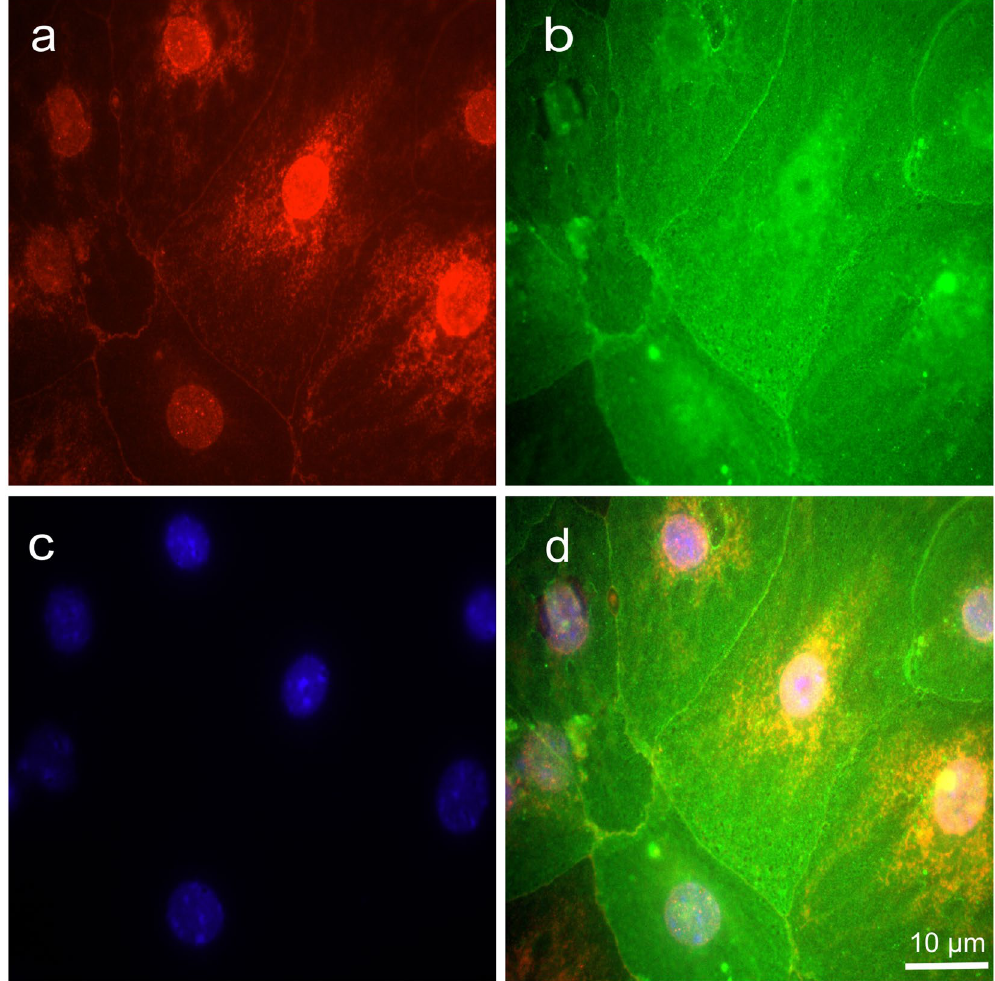
Figure 3. Primary mouse ATI-like cells express COX-2. Cells grown in chamber slides for 6 days were stained with antibodies directed ( a ) against COX-2 (red), followed by incubation with ( b ) an anti-AQP5 antibody (green), a marker of ATI-cells. ( c ) Samples were counterstained with DAPI (blue) to reveal localization of nuclei; ( d ) shows the overlay. Images are representative for 5 independent